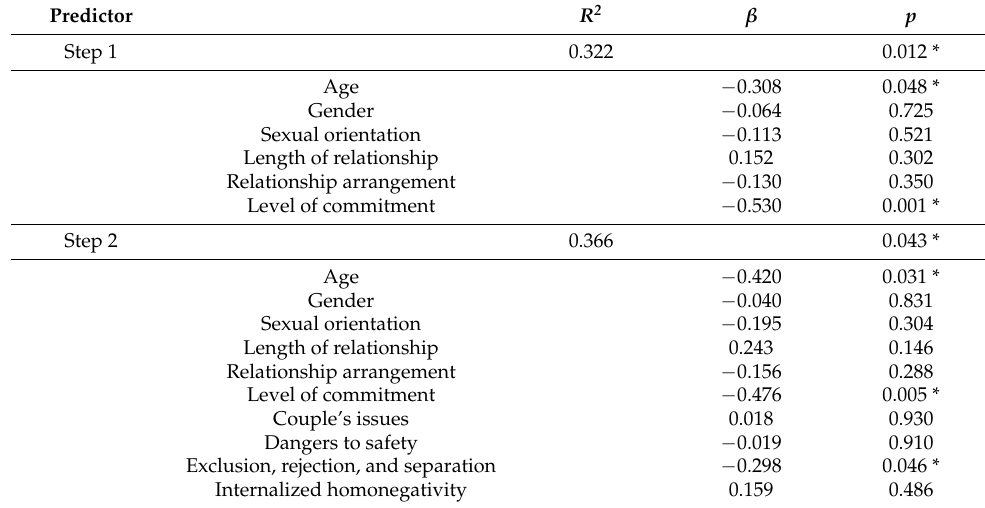
Table 7. Hierarchical Multiple Regression Analysis Predicting Relationship